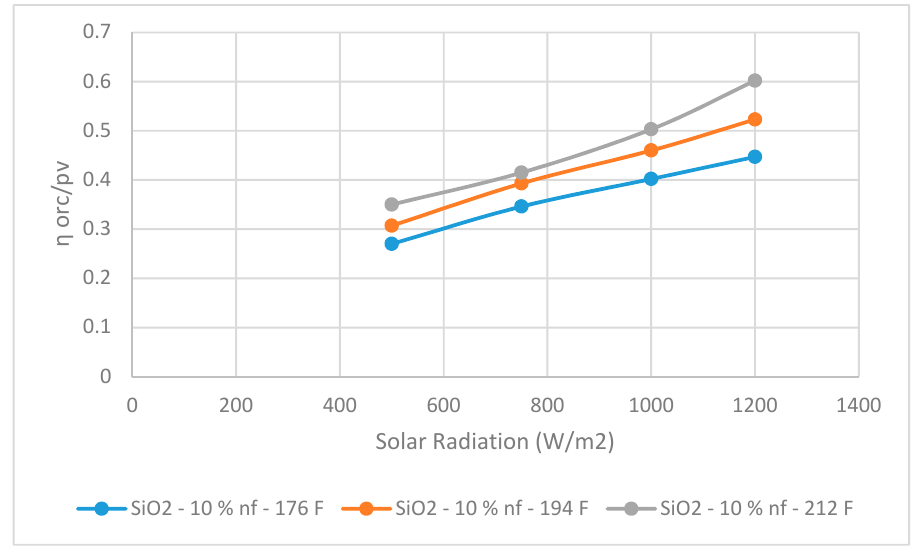
Figure 6. Hybrid system efficiency for Nanofluid Al 2 O 3 at different temperatures and 20% volumetric concentration.